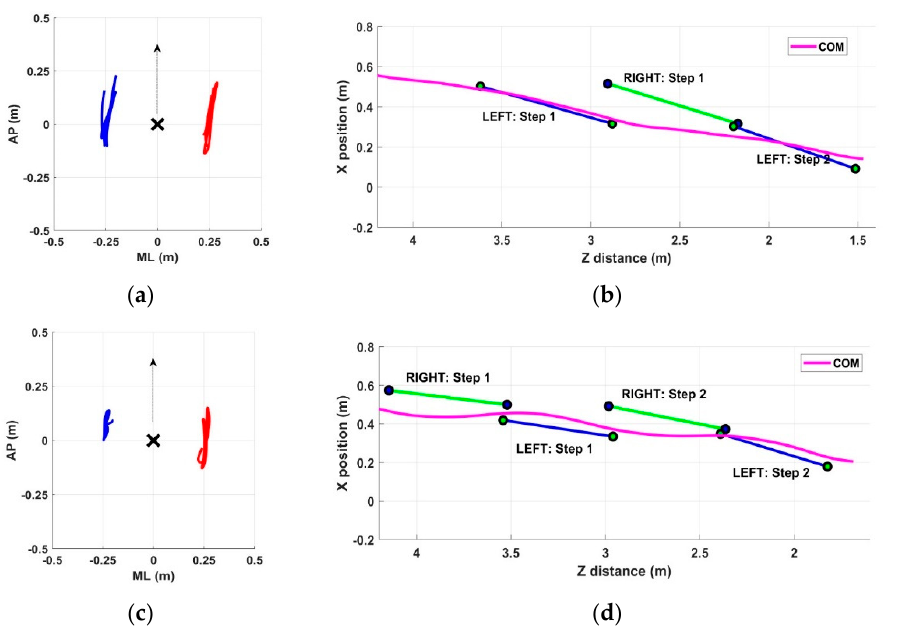
Figure 3. Example of arm swing trajectories (in meters) and gait patterns for HC subjects. ( a ) Subject #5: arm swing in AP and ML directions for left arm (red line) and right arm (blue line) relative to pelvis joint (black cross); ( b ) subject #5: gait patterns with detected steps and center-of-mass trajectory within the GAP zone; ( c ) subject #3: arm swing in AP and ML directions for left arm (red line) and right arm (blue line) relative to pelvis joint (black cross); ( d ) subject #3: gait patterns with detected steps and center-of-mass trajectory within the GAP zone.